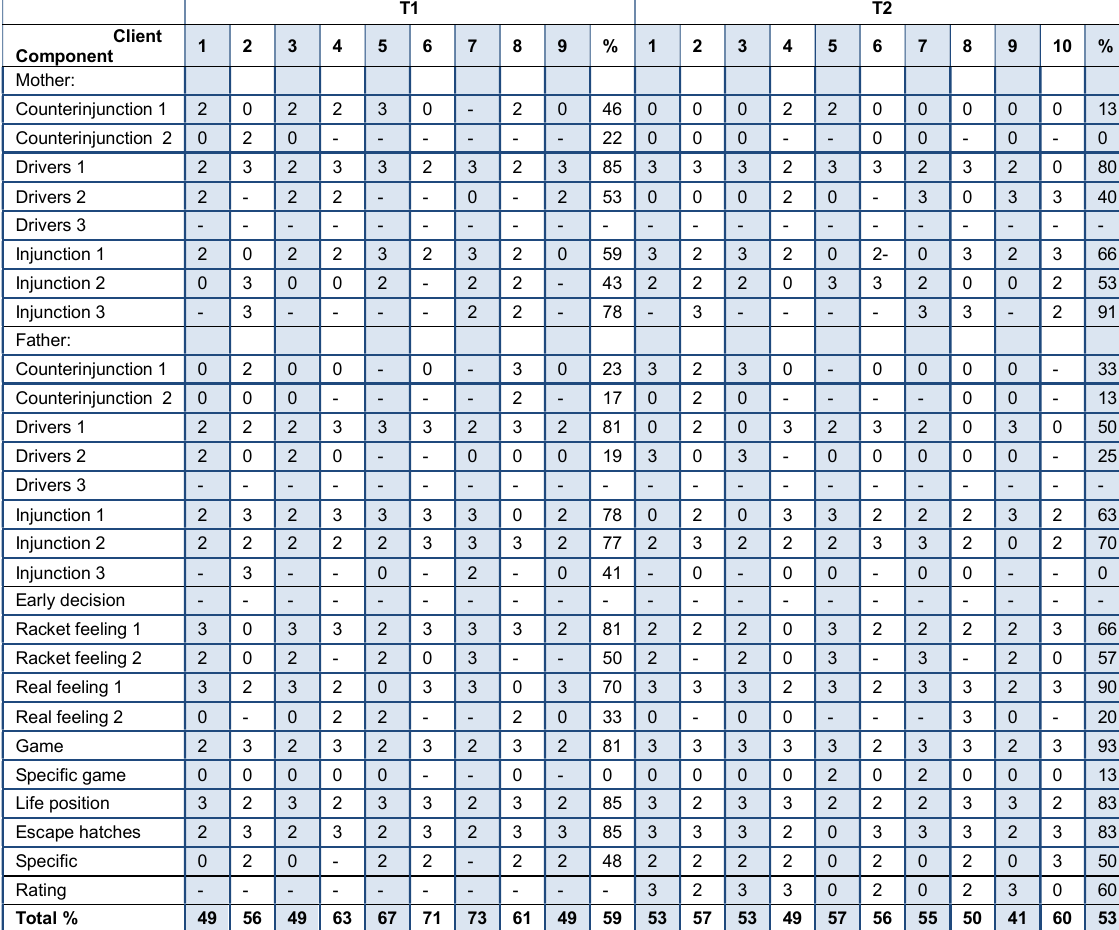
Table 3: Percentage of inter-assessor reliability for all clients, components and total